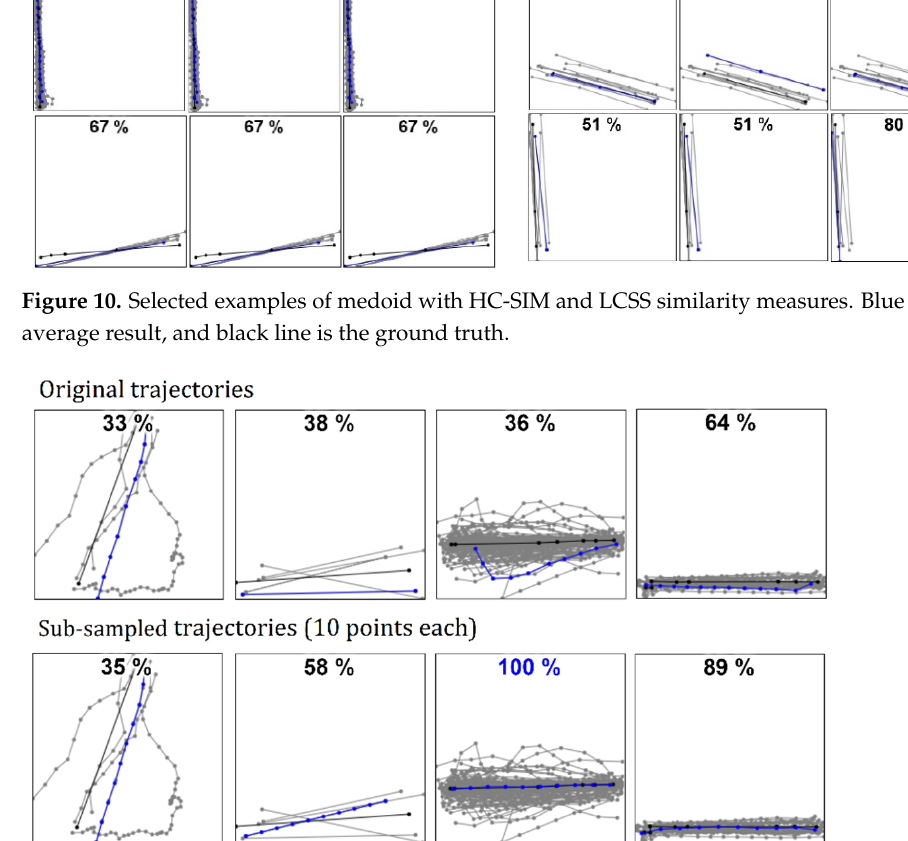
Figure 11. Pre-processing the trajectories by re-sampling can overcome some issues of medoid. LCSS measure was used in these examples. The re-sampling (to 10 points) is shown only for the segment average (blue line).